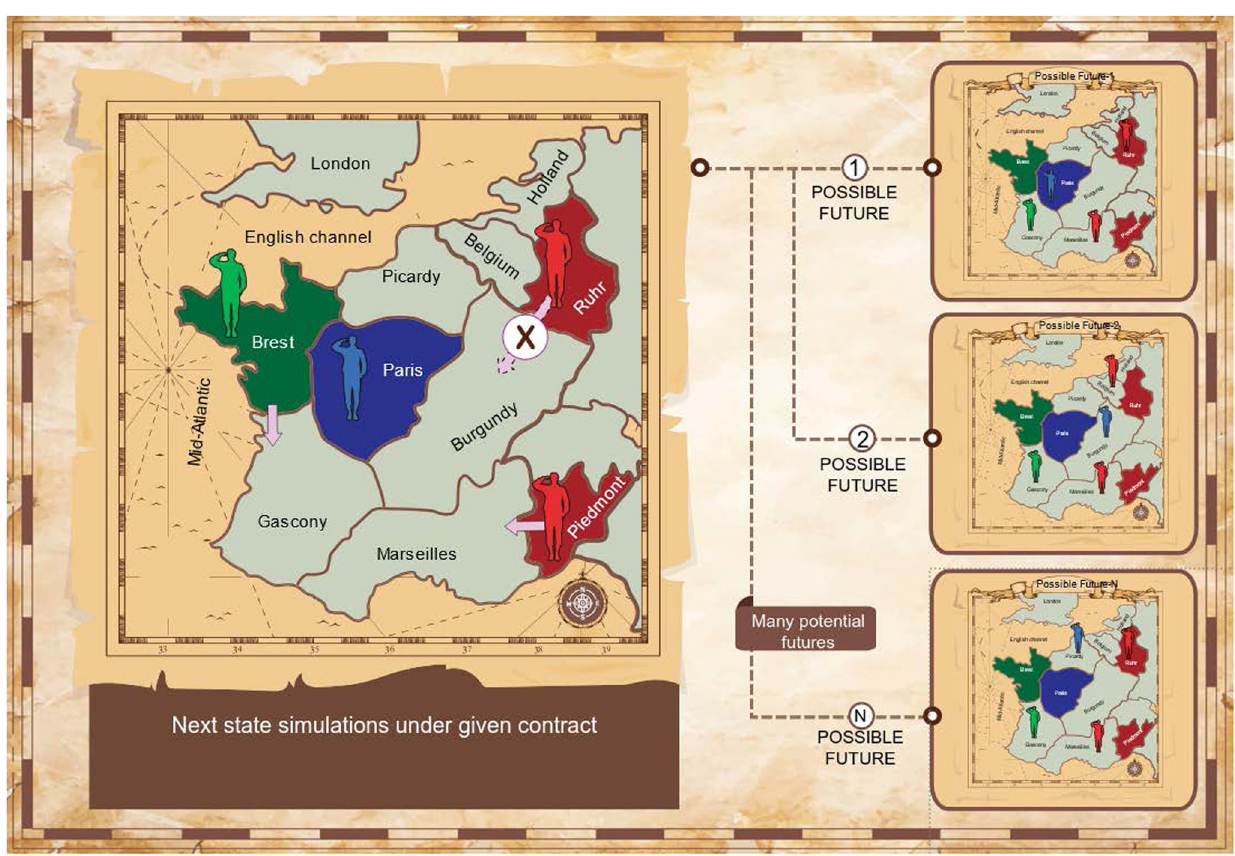
Fig. 3 | Simulating possible next states given agreed contracts. Left: current state in a part of the board, and a contract D =( R i , R j ) agreed between the Red and Greenplayers(sameasinFig.2).Right:multiplepossiblenextstates;theactionsof Red and Green are sampled from the restricted policies π R i , π R j allowing only